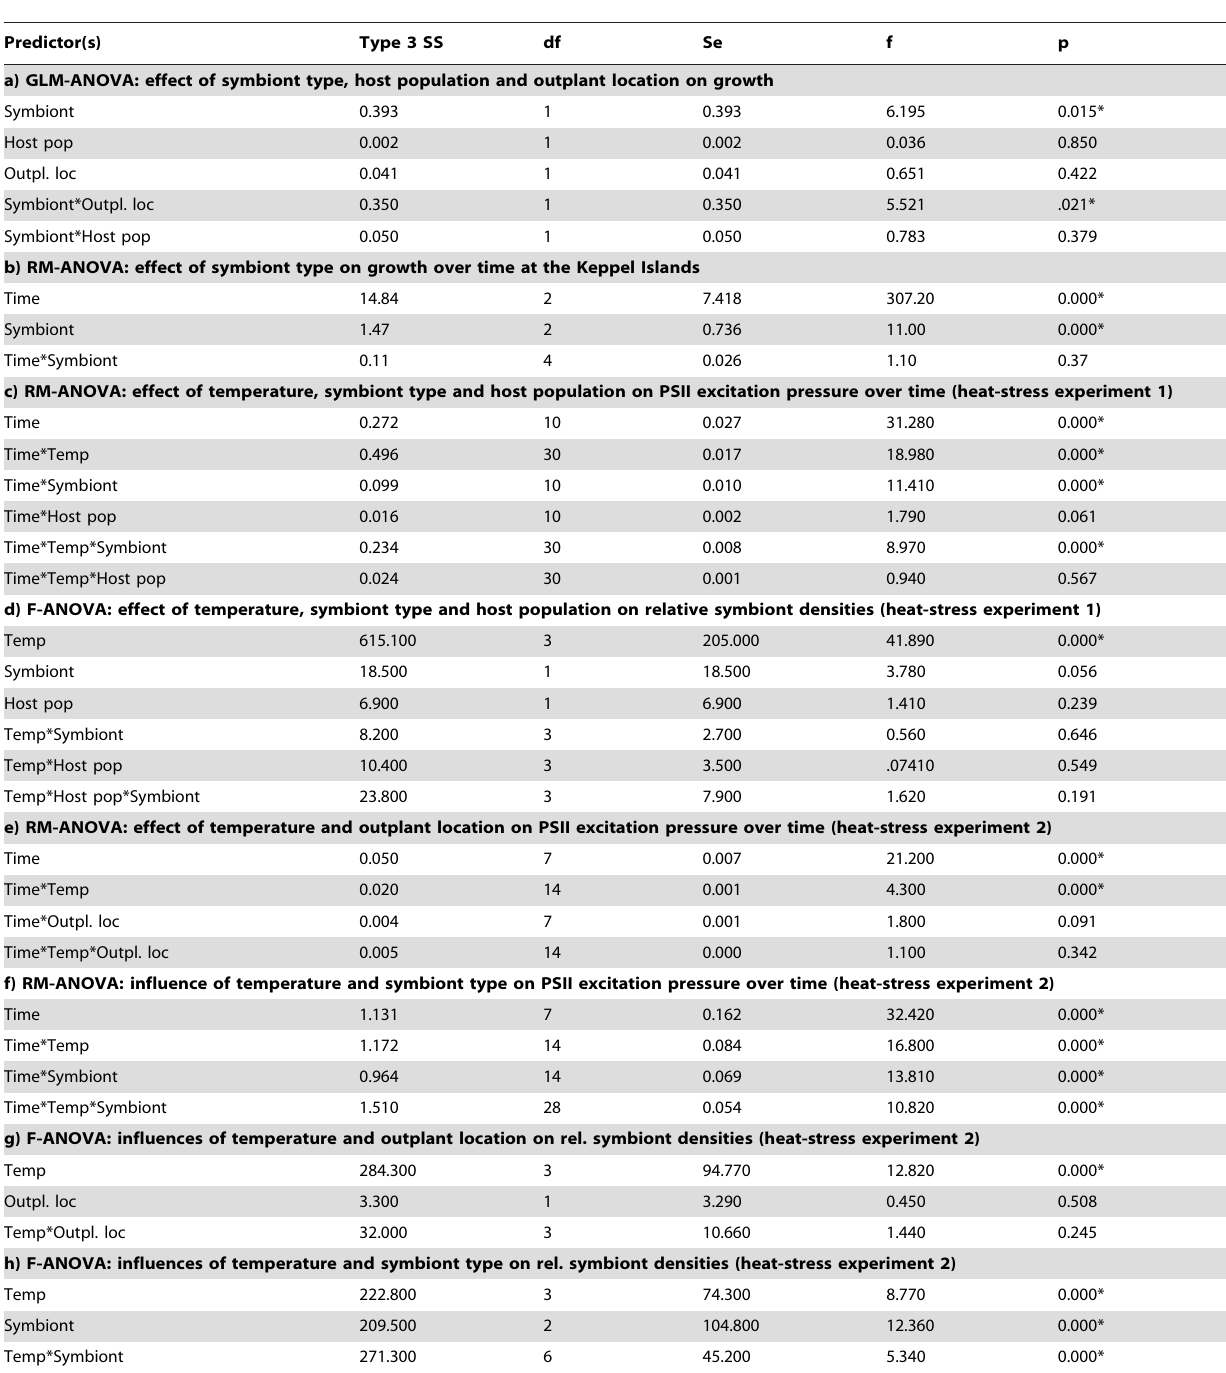
Table 1. Results of ANOVA analyses. GLM =General Linear Model, RM =Repeated Measures, F =Factorial.